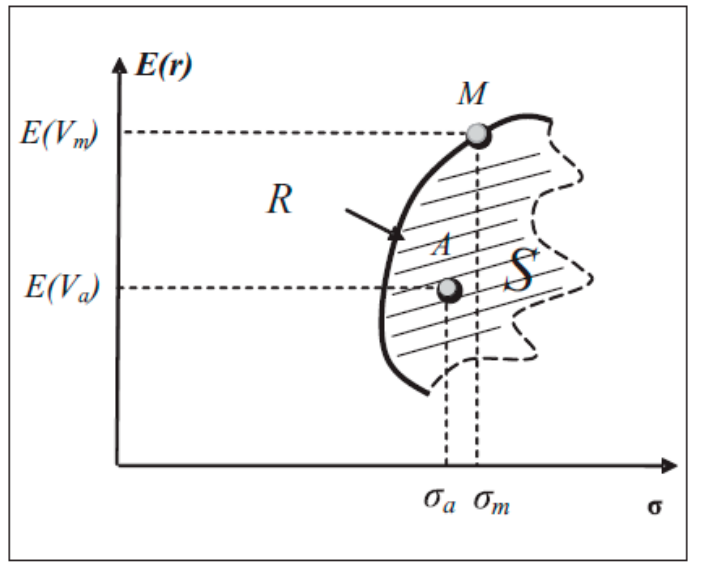
Figure 2. Ratio of portfolio return level and risks.